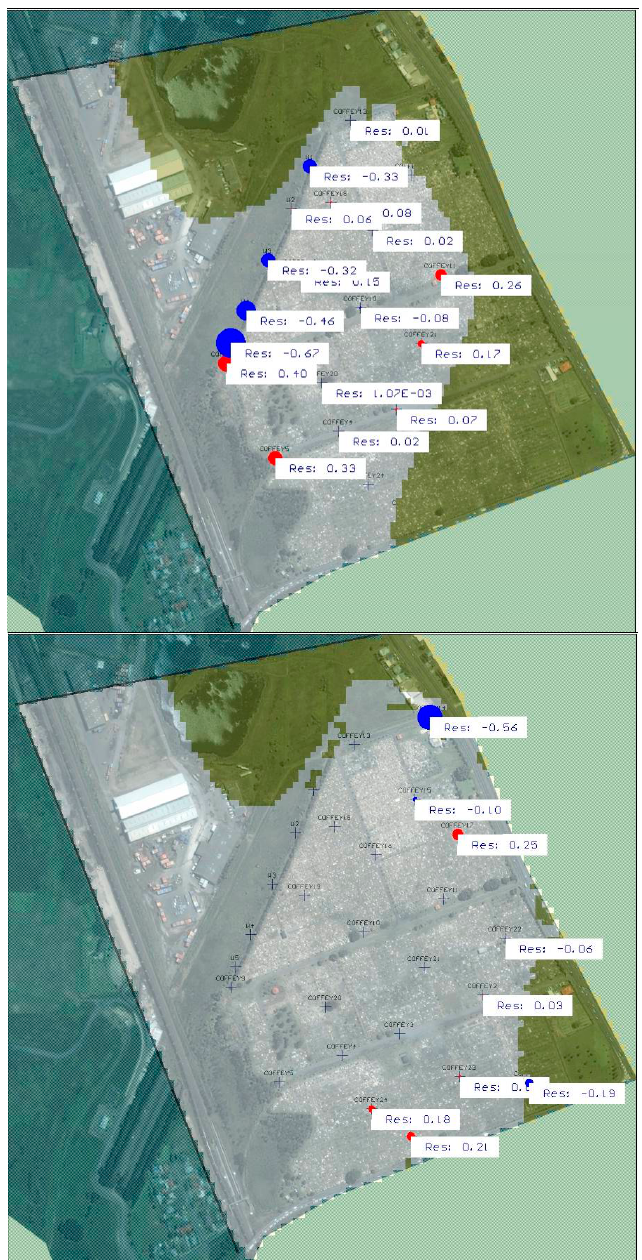
Figure 10. Scenario 1—Layer 1 and Layer 2 residual heads. Blue dots indicate positive (under estimation) and red dots indicate negative (over estimation) values. The size indicates the level of residual error.